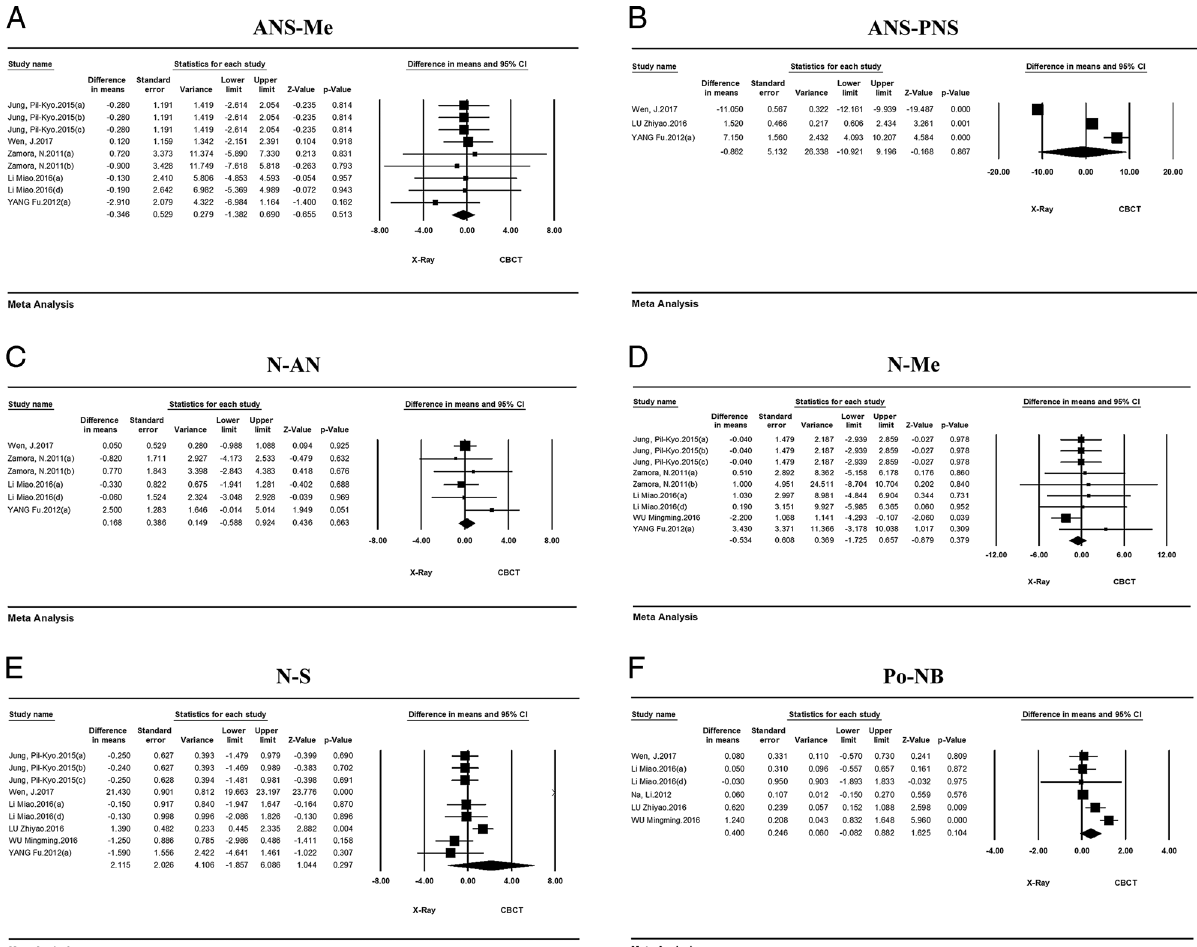
Figure 3. Forest plots of pooled DM for the CBCT group versus the X-ray group (A) ANS-Me, (B) ANS-PNS, (C) N-ANS, (D) N-Me, (E) N-S, (F)